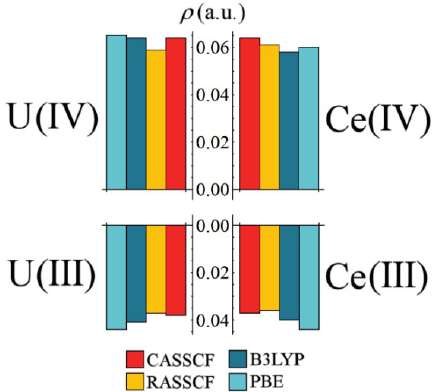
Figure 3. Comparison of (cid:2025) at the M–Cl bond critical point for tri- and tetravalent cerium and uranium